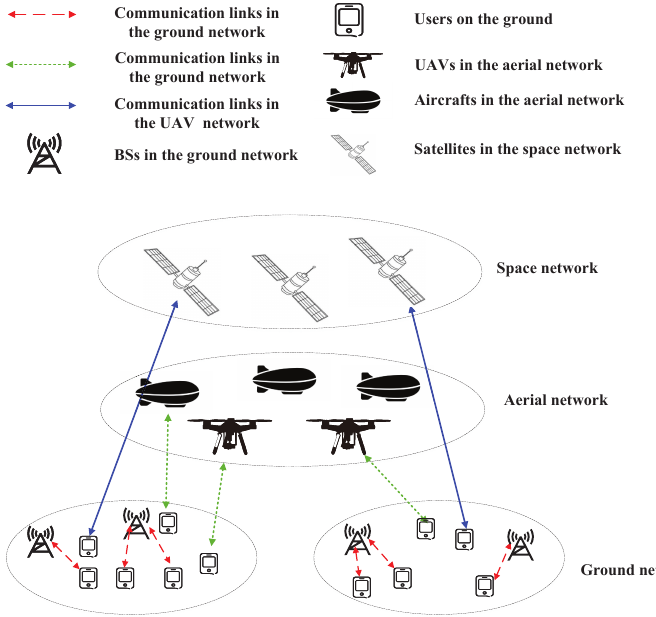
Figure 4. The space–air–ground integrated